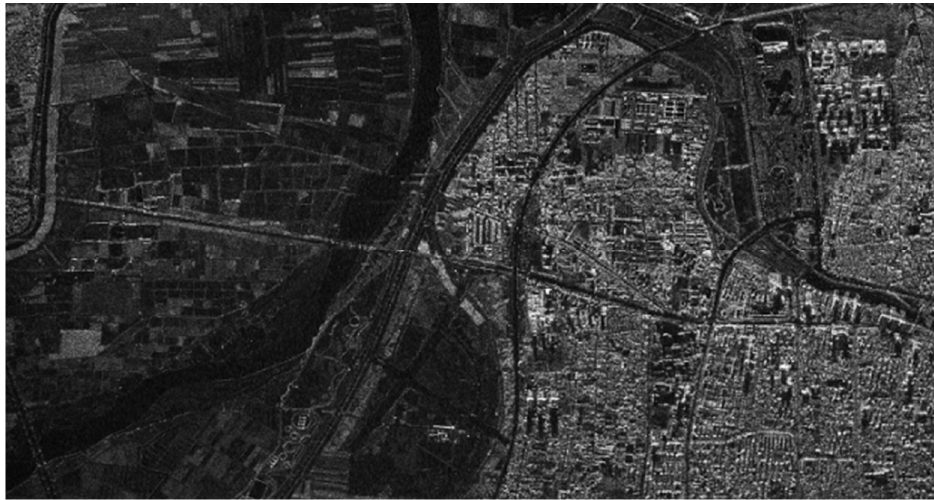
Figure 14. The schematic diagram and processing chain. ( a ) Schematic diagram. ( b ) Processing chain.